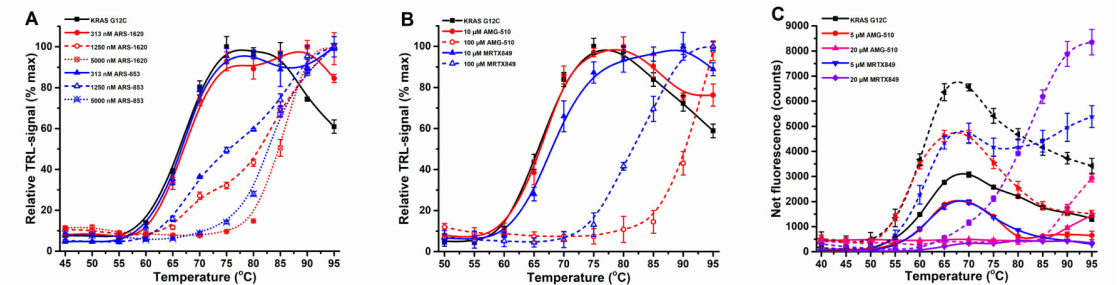
Figure 4. Covalent KRAS G12C inhibitors in the KRAS thermal stability assay. ( A ) 50 nM KRAS G12C (black) was stabilized in a concentration-dependent manner by both ARS-1620 (red) and ARS- 853 (blue) inhibitors (313–5000 nM) in the Protein-Probe assay. ( B ) 50 nM KRAS G12C (black) was stabilized in a concentration-dependent manner by AMG-510 (red) and MRTX849 (blue) inhibitors in the Protein-Probe assay. ( C ) 6 µ M KRAS G12C (black) was concentration-dependently stabilized by AMG-510 (red scale) and MRTX849 (blue scale) inhibitors in the SYPRO Orange (solid line) and ANS (dashed line) assays. No thermal shift was detected with 5 µ M AMG-510, but the second transition was visible with the same concentration of MRTX849. An increase in AMG-510 concentration induced a significant signal quenching of both SYPRO Orange and ANS dyes. Data represent mean ± SD ( n =